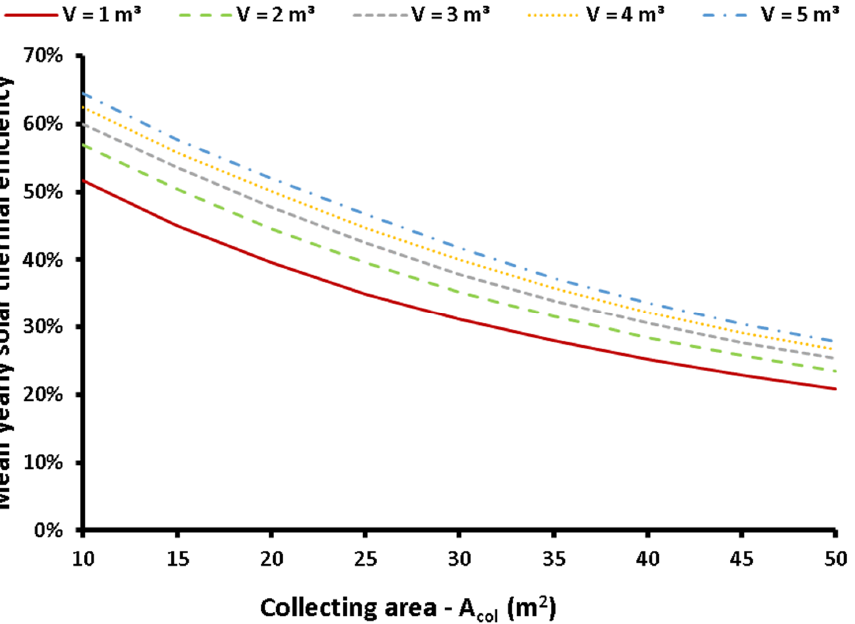
Figure 11. Mean yearly solar thermal efficiency of the collectors for different combinations of (A col ) and (V). and